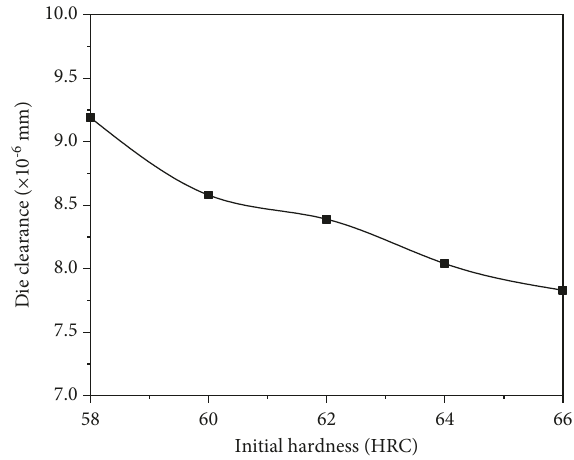
Figure 8: Effect of initial hardness of die on die